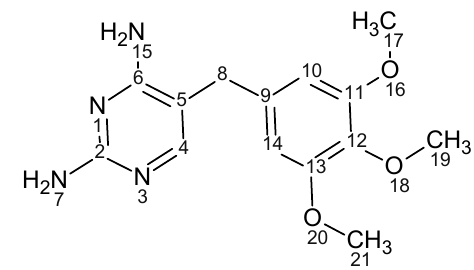
Figure 1. Trimethoprim chemical